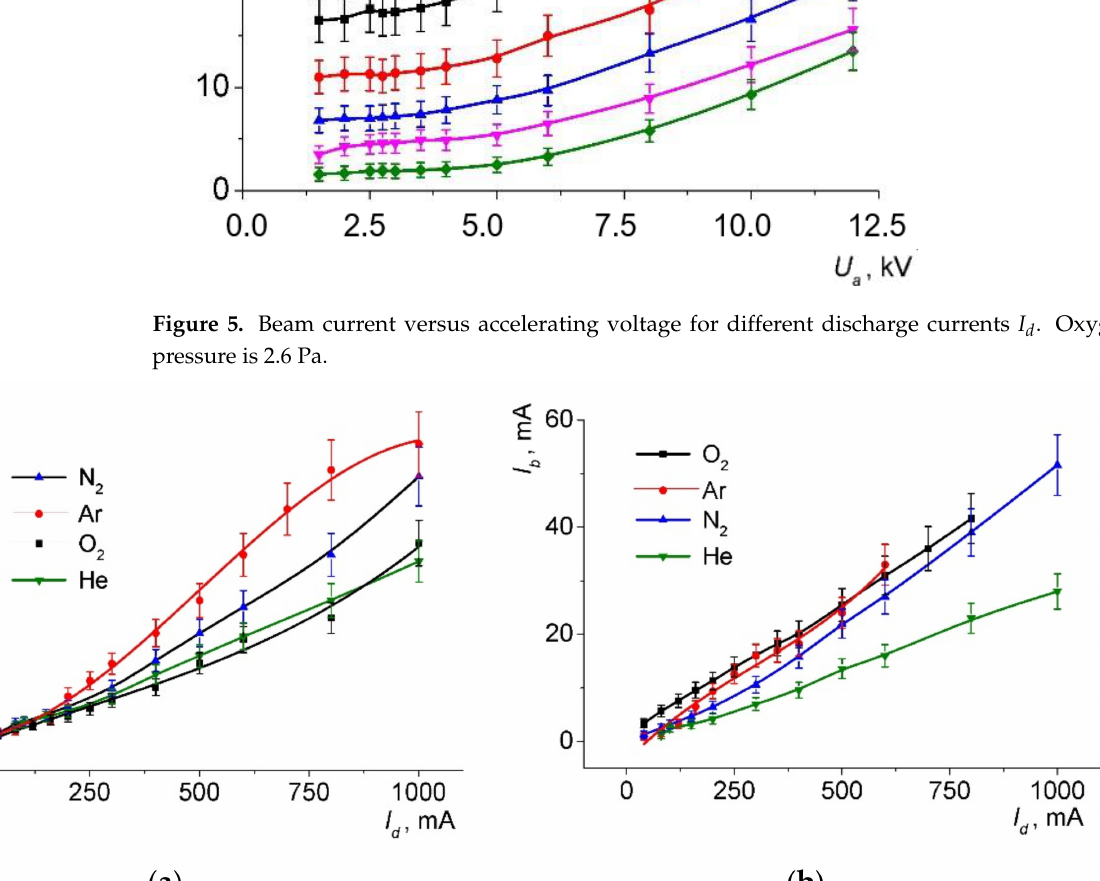
Figure 6. Beam current as a function of discharge current for various pressures: ( a ) 2.6 Pa and ( b ) 4.2 Pa. Accelerating voltage is 8